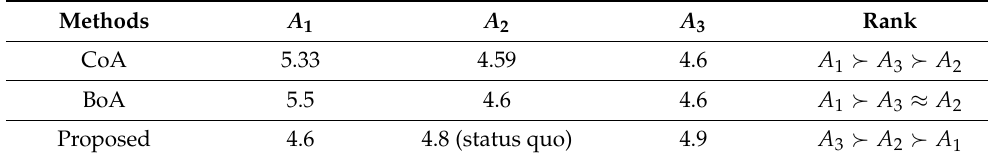
Table 4. The comparison of defuzzifying approaches in Example